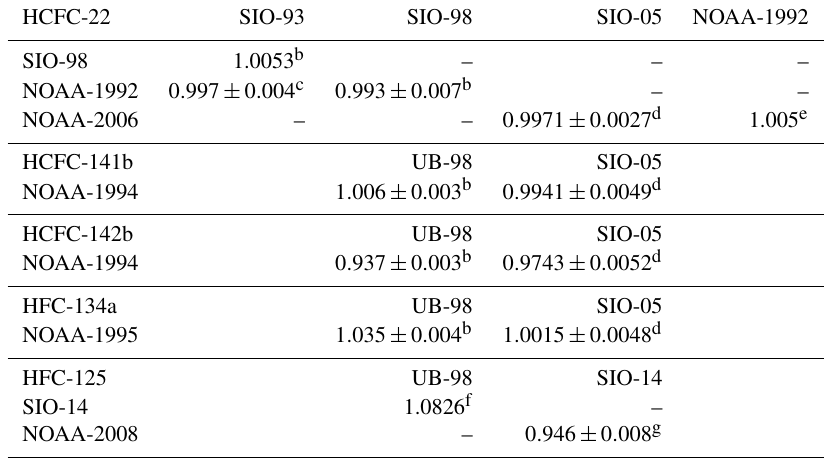
a Example: for HCFC-22 measurement results reported on the SIO-98 scale, multiply 1.0053 to convert to the SIO-93 scale. AGAGE: Advanced Global Atmospheric Gases Experiment, UB: University of Bristol, SIO: Scripps Institution of Oceanography, NOAA: National Oceanic and Atmospheric Administration. b Prinn et al. (2000). c Miller et al. (1998). d Prinn et al. (2018a). e NOAA calibration scales for various trace gases (https://www.esrl.noaa.gov/gmd/ccl/scales.html, last access: 20 December 2018). f AGAGE calibration scale (http://agage.eas.gatech.edu/data_archive/agage/AGAGE_scale_2018_v1.pdf, last access: 20 December 2018). g Simmonds et al.